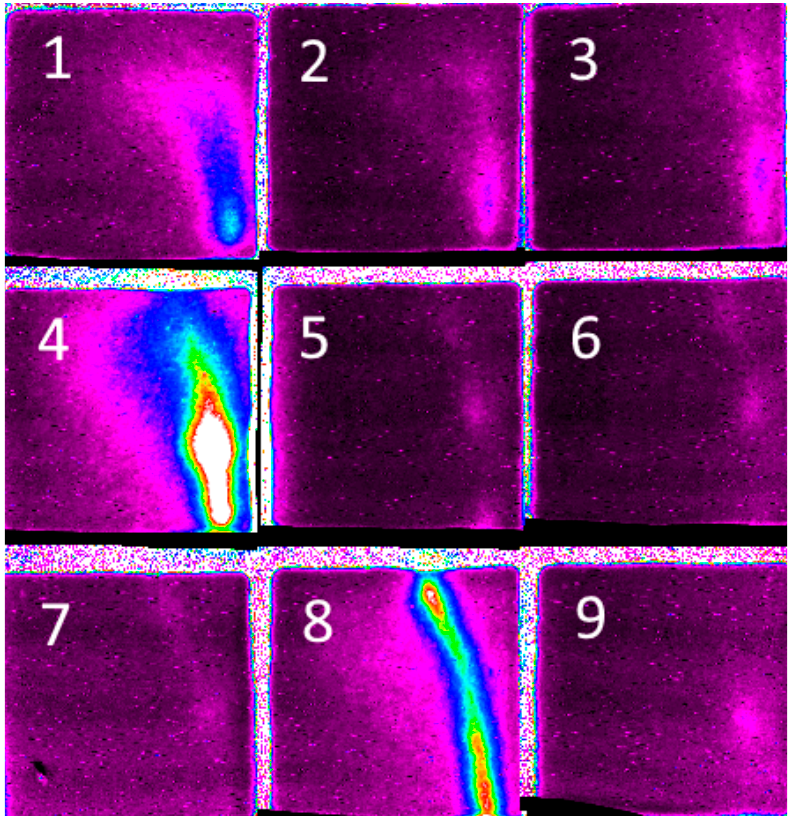
Figure 13. Characteristic dynamics of formation of the first and repeated discharge from the system of artificial thunderstorm cells of positive polarity with the participation of lower and upper groups of model hydrometeors at a more powerful first discharge (frame size 85 × 85 cm, frame duration 2.5 µ s, pause 0.1 µ s). Table 4. Parameters of main stage discharge current pulses from the system of artificial thunder- storm cells of positive polarity involving two groups of model hydrometeors (mean value, range).